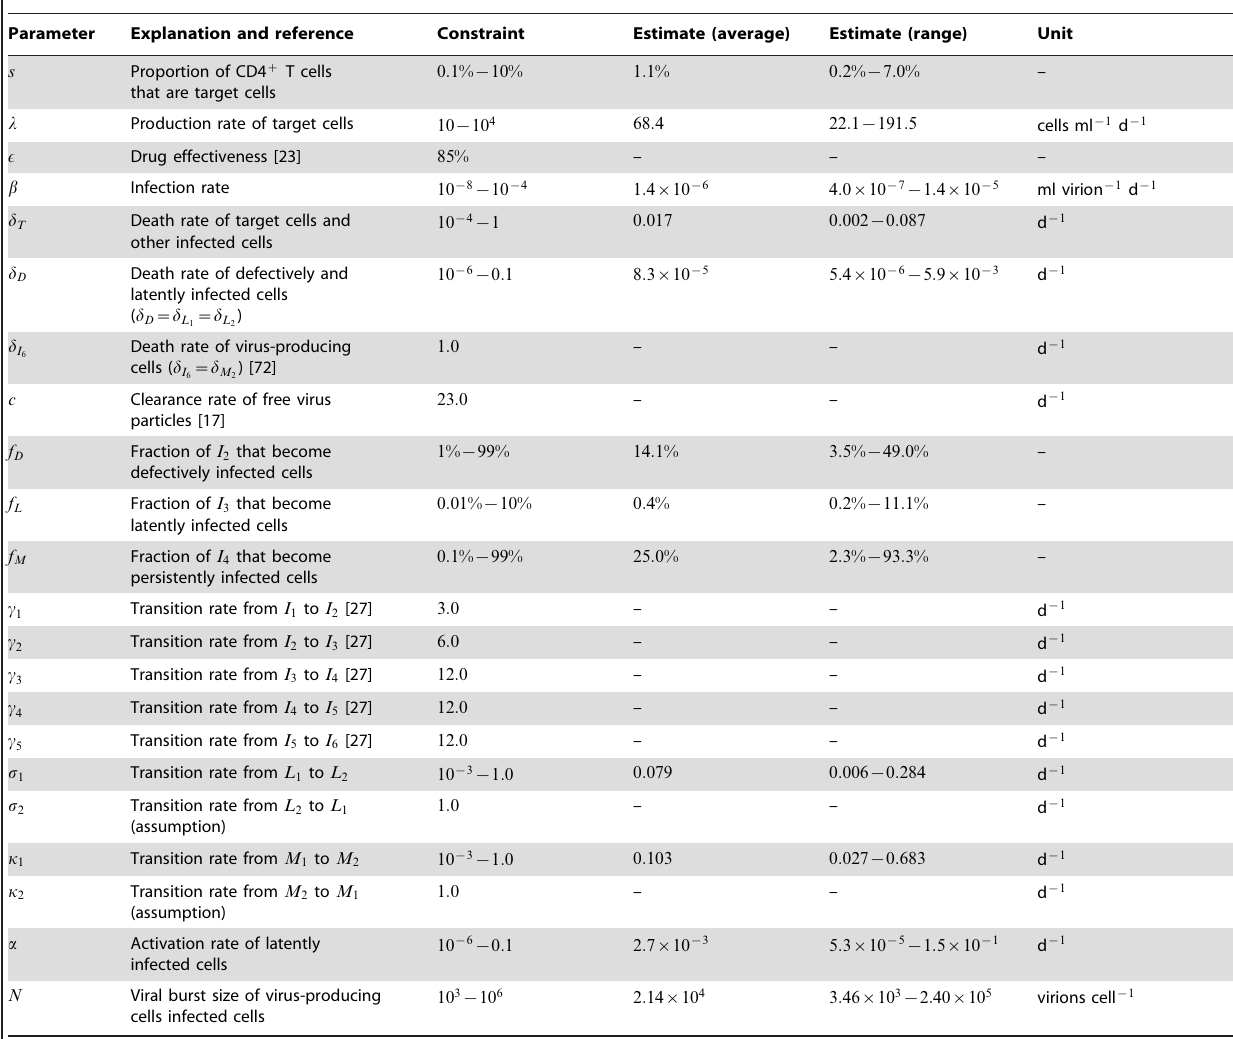
Table 1. Estimated parameters of HIV-1